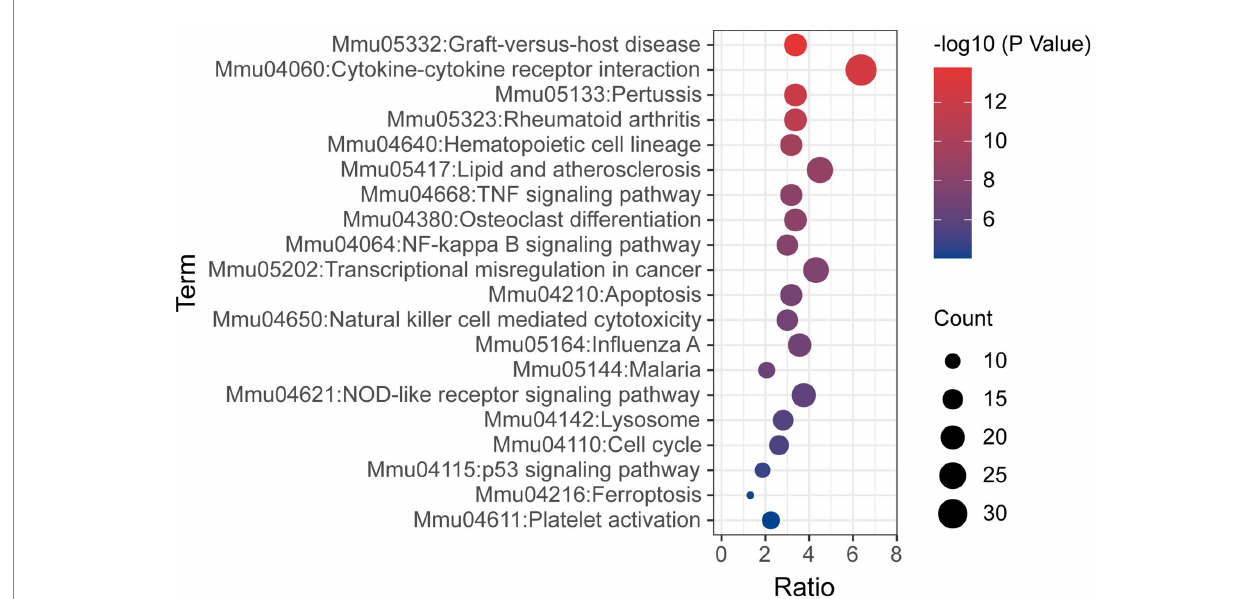
FIGURE 6 Bubble graph representing KEGG pathways from the enrichment analysis of differentially expressed mRNA post-ICH. The top 20 enriched terms were shown ranked by value of p , and the size of bubbles represents the gene counts corresponding to the